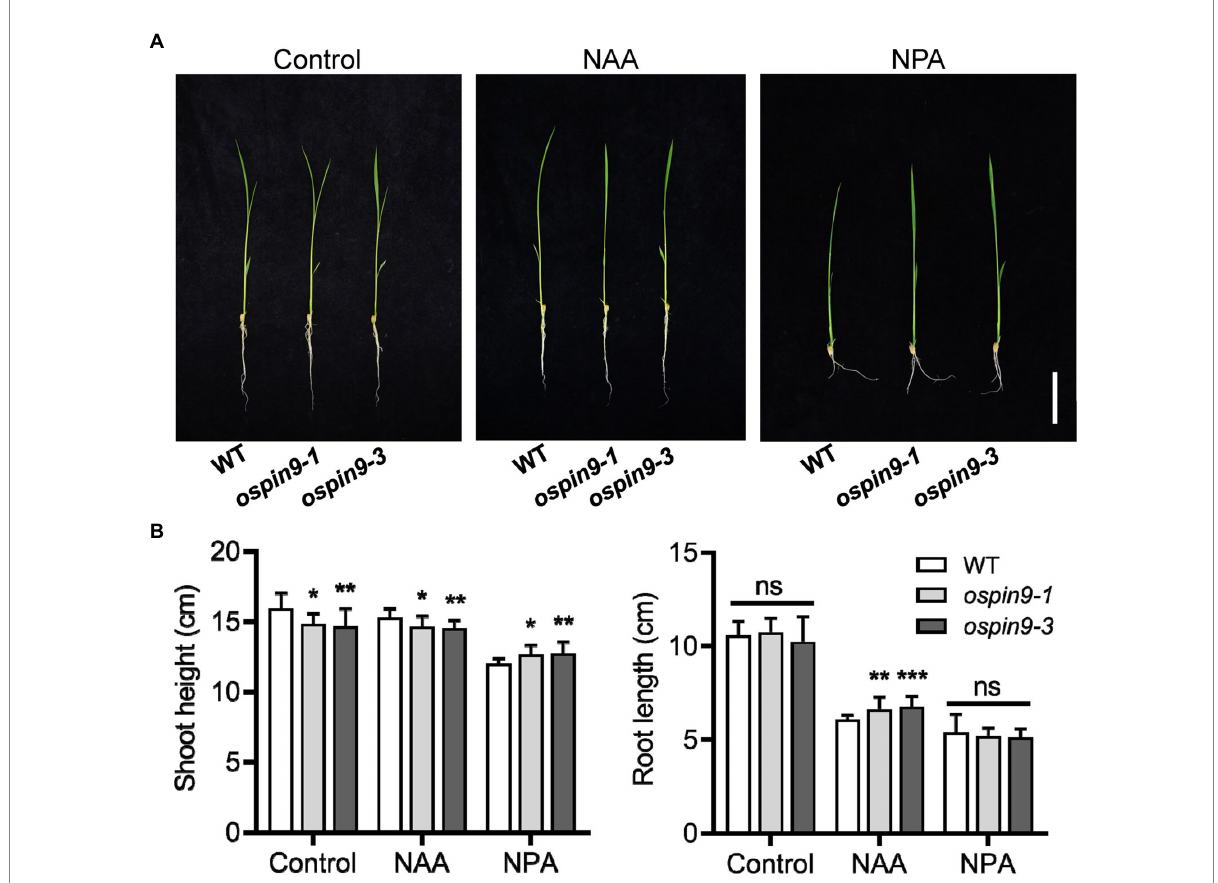
FIGURE 3 Response of WT and ospin9 mutants to NAA and NPA treatment. (A) Phenotype of WT and ospin9 mutants under normal, NAA or NPA treatment. Bar = 5 cm. (B) Shoot height and root length of WT and ospin9 mutants under normal, NAA or NPA treatment. Values are means ± standard deviation (SD; n = 15). Data were analyzed by ANOVA and Tukey’s tests at p < 0.05 significant